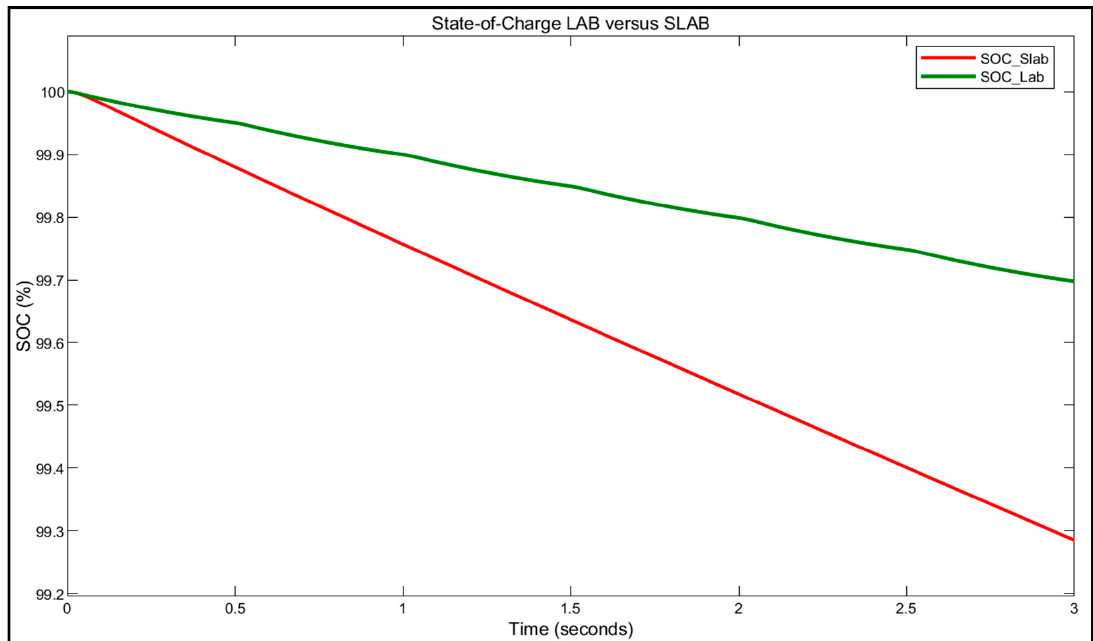
Figure 21. LAB SoC versus SLAB during discharging modes.